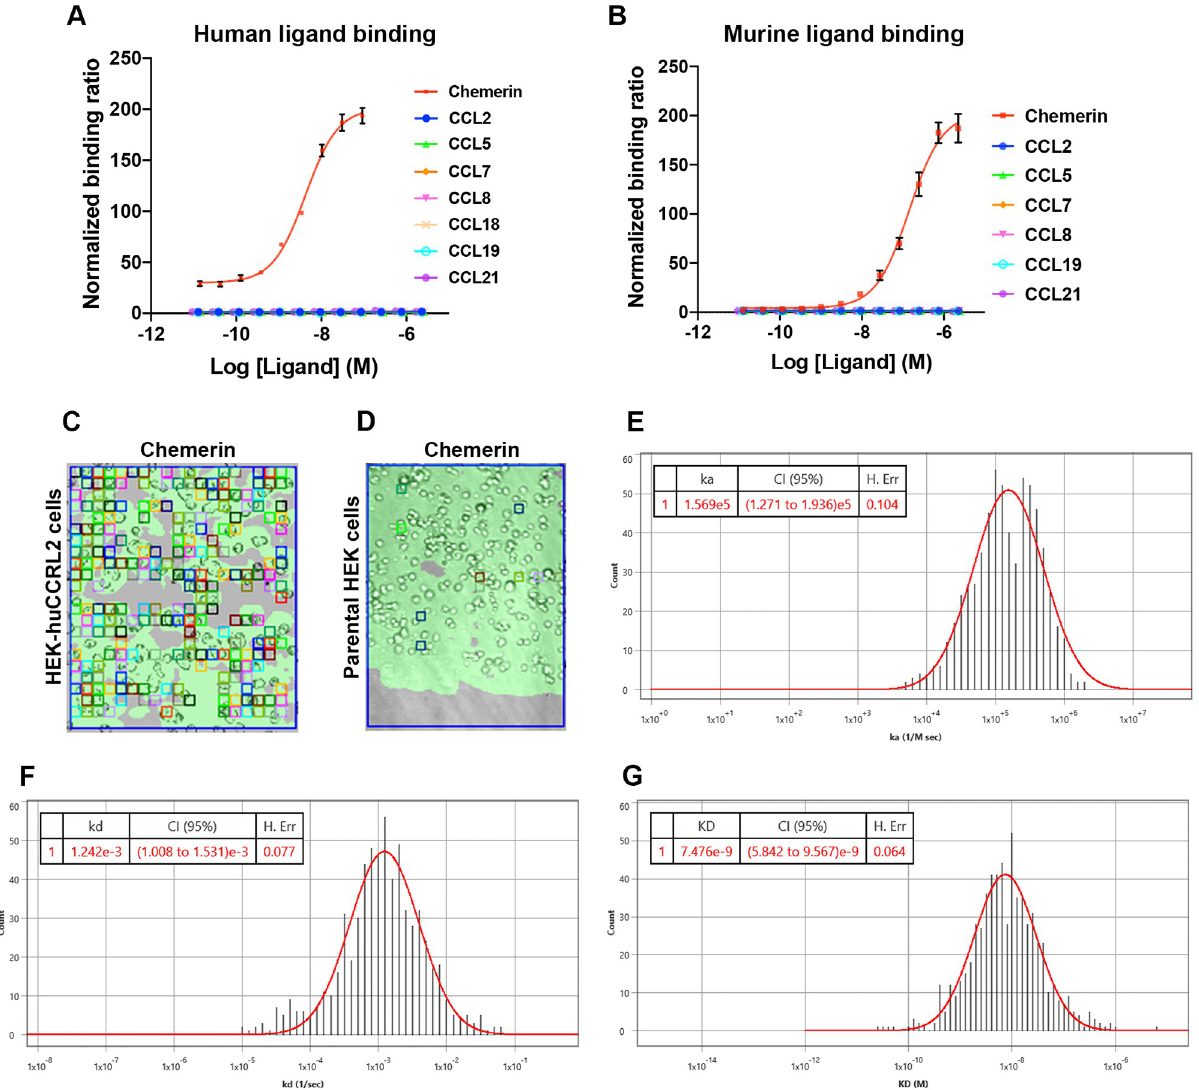
Fig 1. Chemerin binds cell surface expressed CCRL2. (A) Biotin-labeled human ligands were incubated with HEK-huCCRL2 cells and (B) biotin- labeled murine ligands were incubated with HEK-muCCRL2 cells for flow cytometry binding experiments. Ligand binding is shown as median fluorescence intensity (MFI) of ligand bound to HEK-CCRL2 cells normalized to parental HEK cell binding, Mean ± SEM (N = 3) for (A) and Mean ± SEM (N � 5) for (B). EC 50 values were determined by performing the log (agonist) vs. response variable slope (four parameter) equation using GraphPad Prism (version 9.0). SPRm brightfield image of (C) human chemerin bound to HEK-huCCRL2 cells or (D) human chemerin bound to parental HEK cells; squares indicate ROIs where chemerin binding events were detected and are representative of N = 3. Representative histogram distributions for (E) on-rate (k on ), (F) off-rate (k off ) and (G) binding affinity (K D ) were generated from kinetic fit of ROI sensorgrams for human chemerin binding to HEK-huCCRL2 cells and are representative experiments of N = 3. Histograms of on-rate (E) and off-rate (F) values generated using Biosensing Instrument Image Analysis Software (version 1.6.2) are assigned units of ka (1/M sec) and kd (1/sec), respectively, but are referred to as k on (M -1 s -1 ) (on-rate) and k off (s -1 ) (off-rate) elsewhere in this manuscript according to conventional nomenclature.